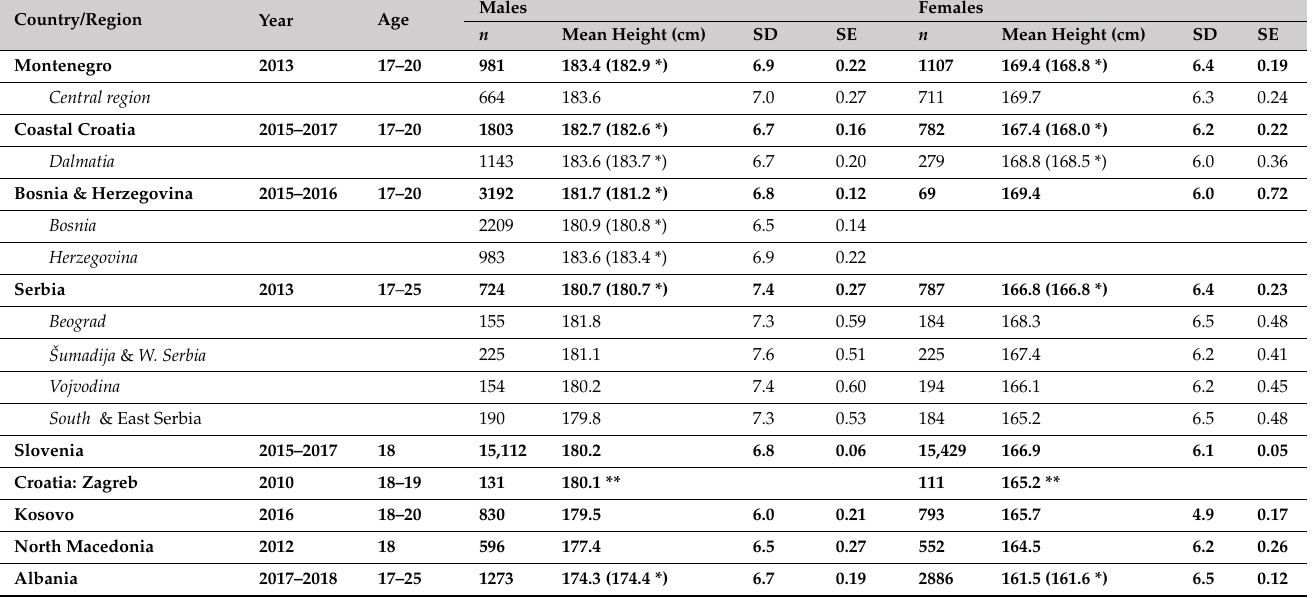
Table 1. Mean height in the former Yugoslavia and Albania (in similar age